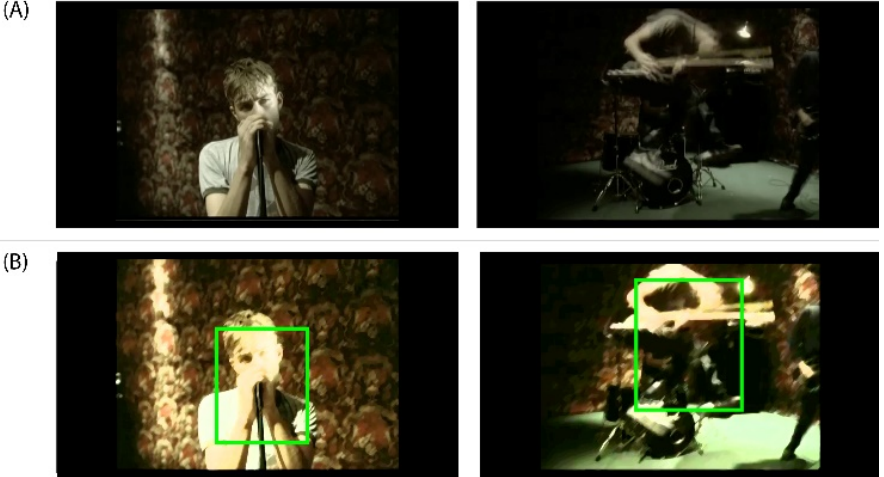
Figure A4. ( A ) DEAP Dataset Experiment_id (5) ‘Song 2’ Music Video from Blur’s album ‘Blur’